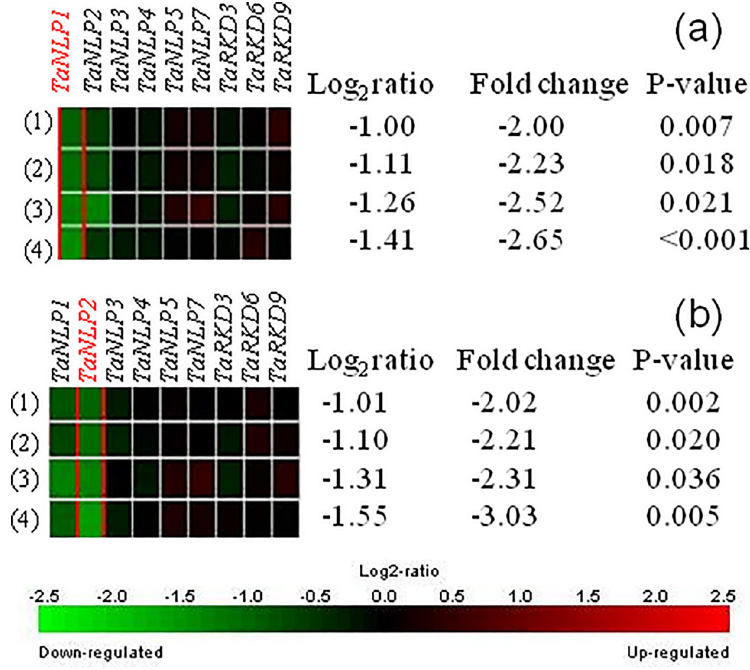
Fig 4. Results of in silico expression analysis of TaRKD and TaNLP genes of wheat under varying doses of nitrogen in four different experiments. (a) Experiment (1)-(3) showing expression at 21 daa under 200 kg N/ha vs. 50 kg N/ha (used as control),using genotype Istabraq in 1 st , Hereward in 2 nd and Soissons in 3 rd , and experiment (4) showing expression at 7 daa under192 kg N/ha vs. 48 kg N/ha (used as control), and (b) Experiment (1)-(2) showing expression at 7 daa at 200 kg N/ha vs. 50 kg N/ha (used as control) and experiment (3)-(4) showing expression at 21 daa under 200 kgN/ha vs. 50 kg N/ha (used as control) using genotype Riband in 1 st and 3 rd and Soissons in 2 nd and 4 th . Genes showing significant differential expression are indicated with red